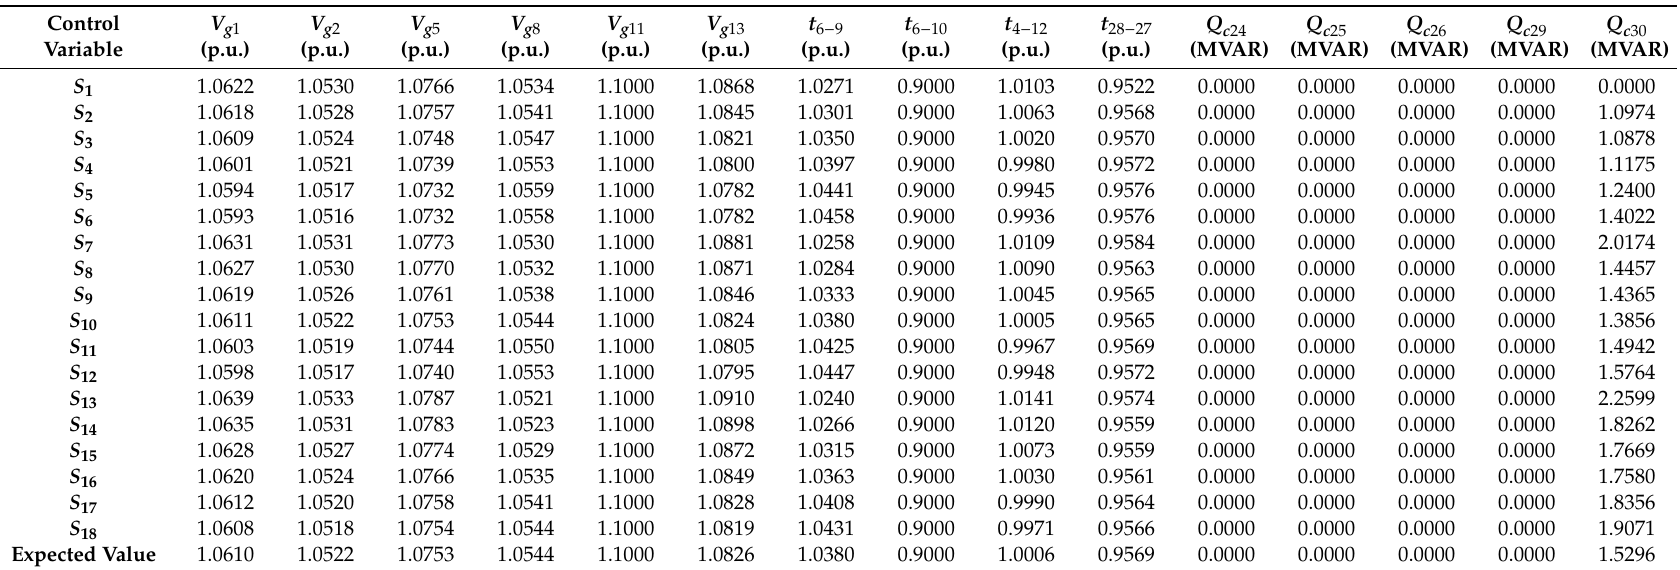
Table 20. The optimal values of the control variables for probabilistic multi-objective RPP considering load demand and wind power generation uncertainties incorporating the generated reactive power by the proposed wind